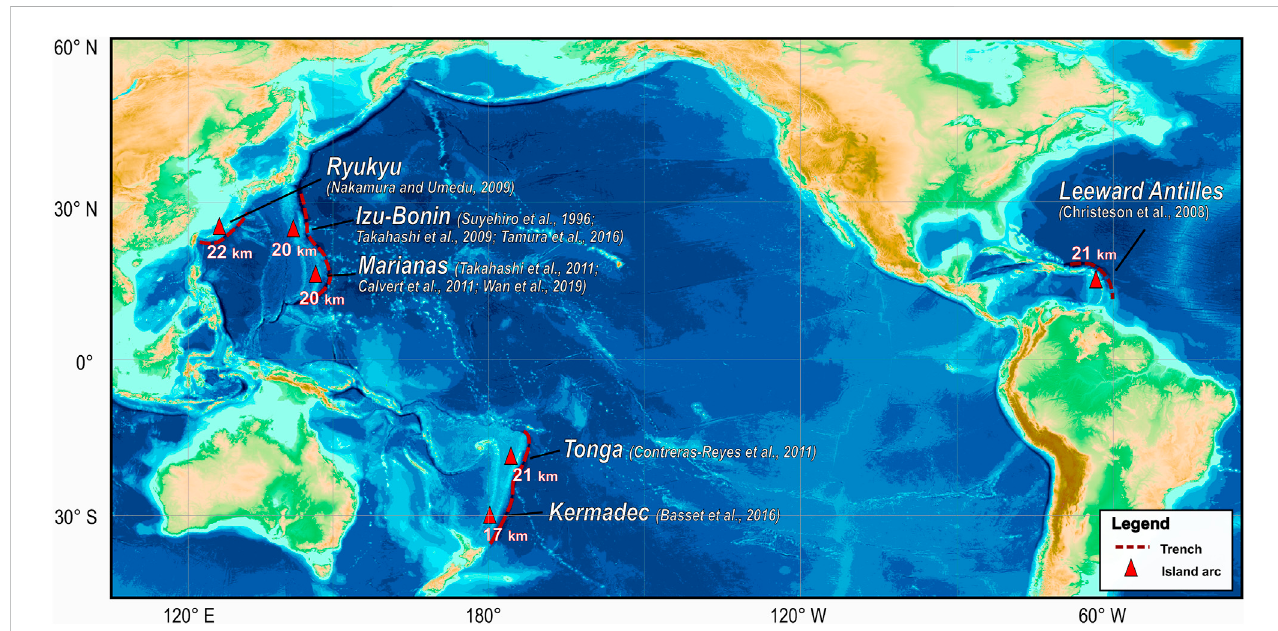
FIGURE 1 Location of the oceanic island arcs used for the regression analysis determining the relationship between crustal thickness and Bouguer anomalies. The numbersshowninthe fi gurerepresenttheaveragecrustalthicknessoftheseoceanicisland arcsderivedfromseismicdata.Bathymetricdatausedinthebase map was extracted from GEBCO (2022).